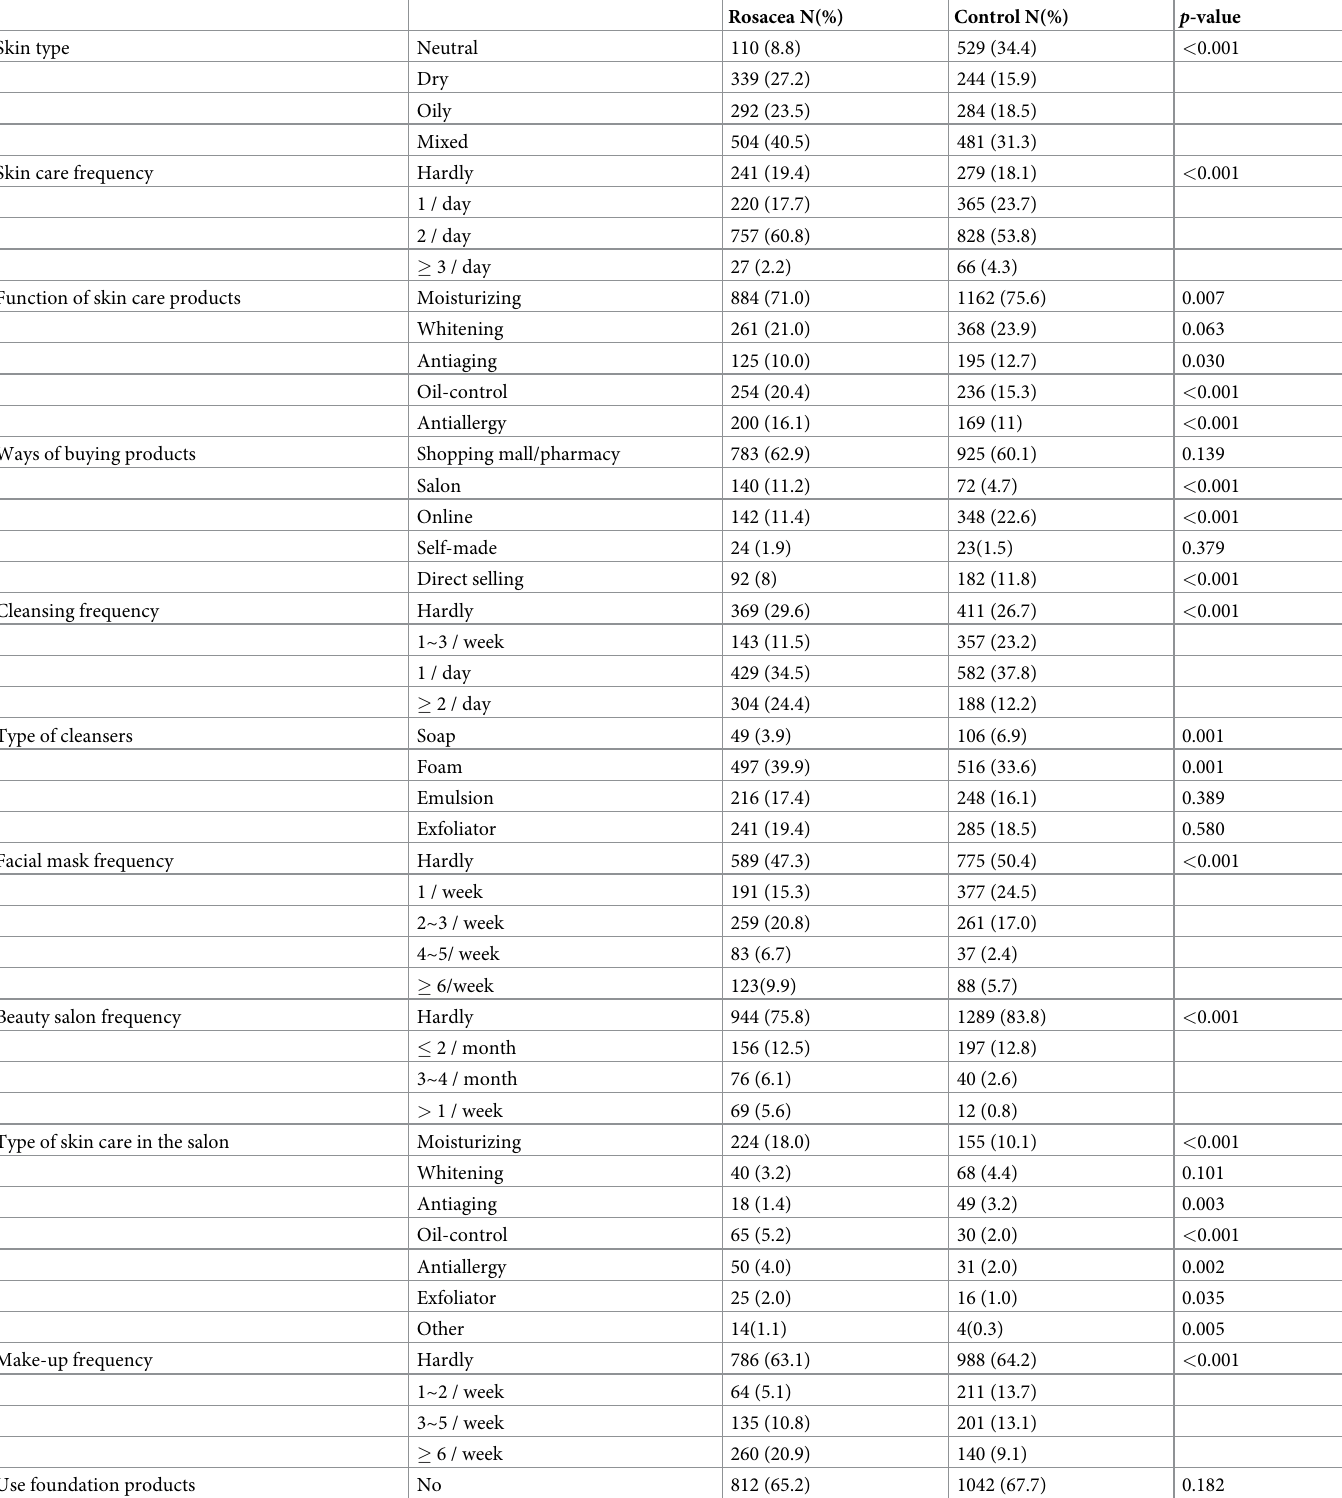
Table 2. Comparisons of skin care habits between the case and control